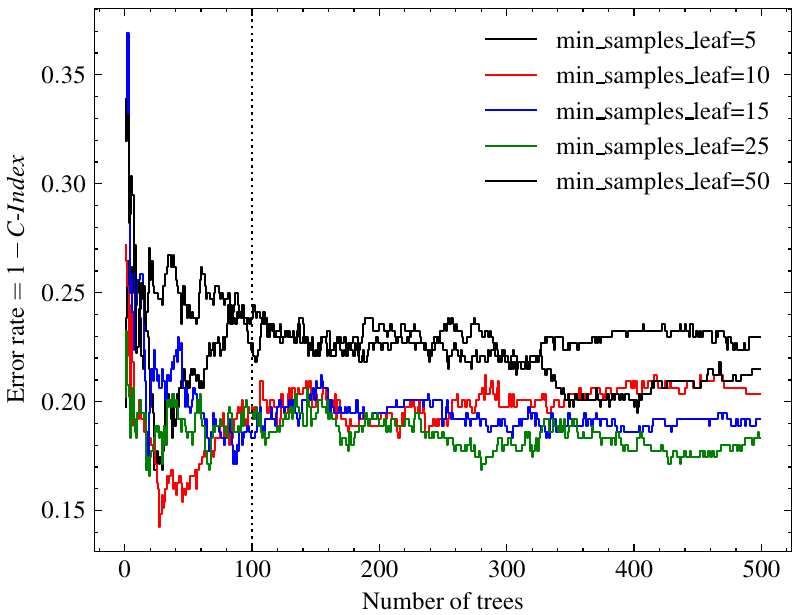
Figure 4. Analysis of the convergence of the RSF model, varying the parameters of the number of base estimators M and the minimum of samples in each node. We adopted a standard sample count of 15, since it achieved the lowest error for ensembles with M = 100